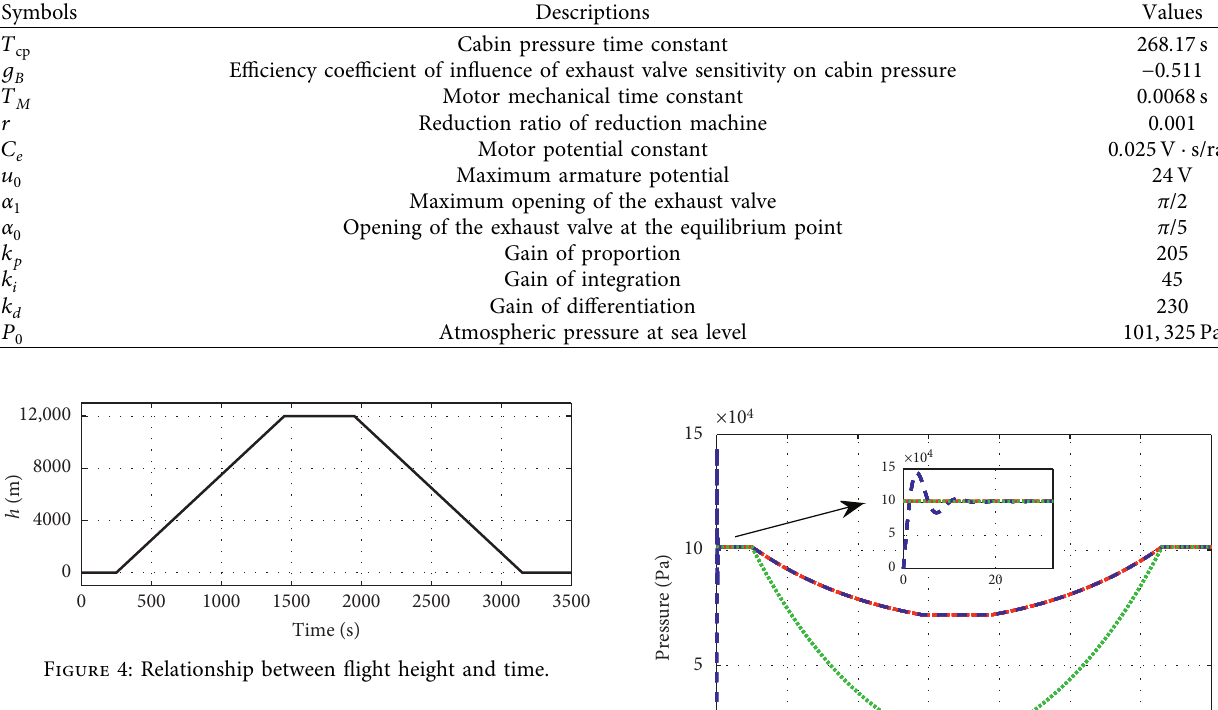
Table 1: Values of model parameters.